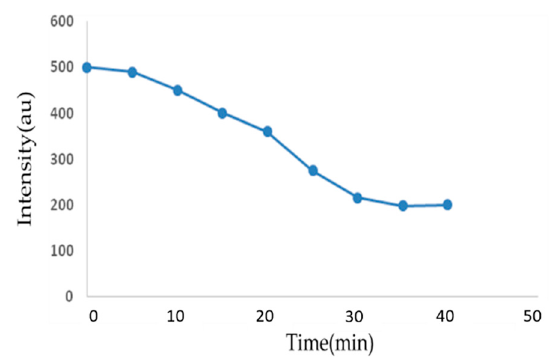
Figure 3. Fluorescence intensity and time plot following progressive binding of bacterial cells to the mannose-coated polymer.